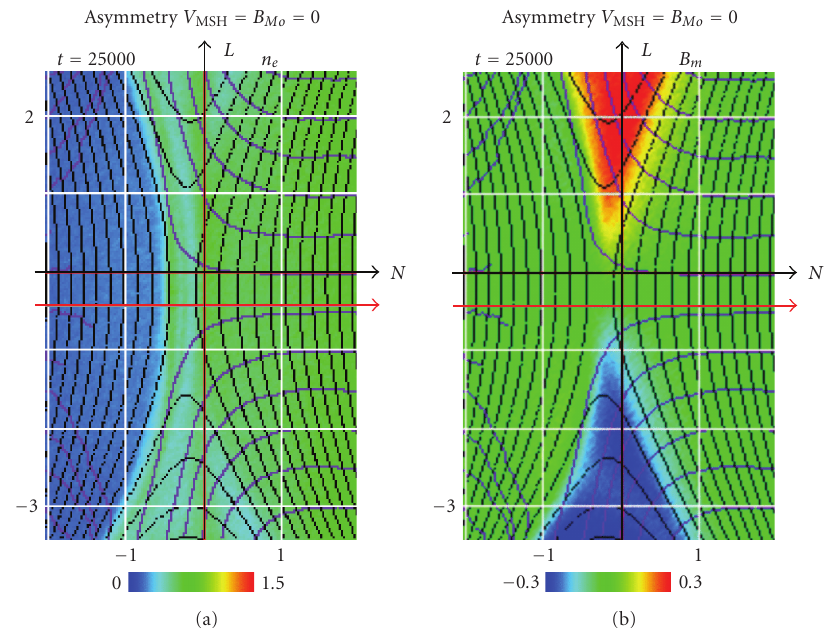
Figure 4: Zooming into the X-line region for the V MSH = B Mo = 0 case. (a) The density and (b) out-of-plane magnetic field B M patterns in the area of [ L XL − 3, L XL + 3] × [ N XL − 2, N XL + 2] are shown. The time is t = 25. The black and purple lines show the field lines and the ion streamlines,